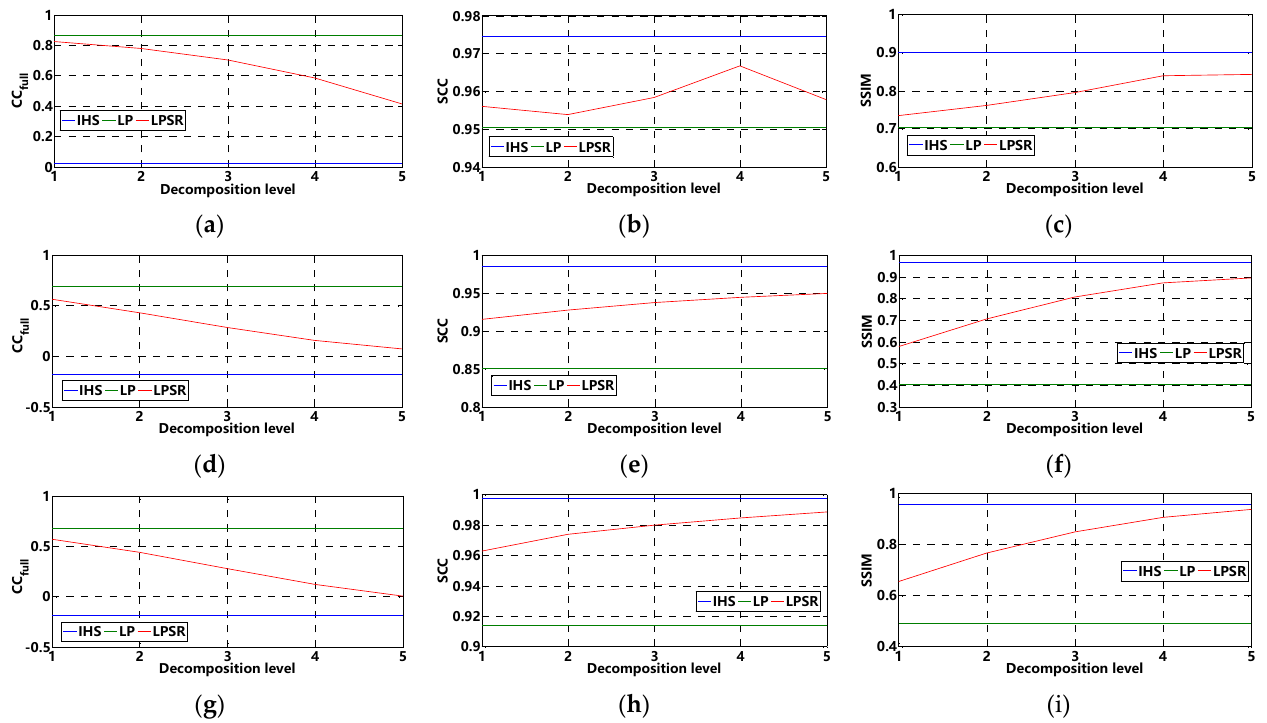
Figure 12. Statistical results of adjustability experiment: ( a – c ) display the CC full , SCC, SSIM values of area 1; ( d – f ) for area 2; ( g – i ) for area 3.